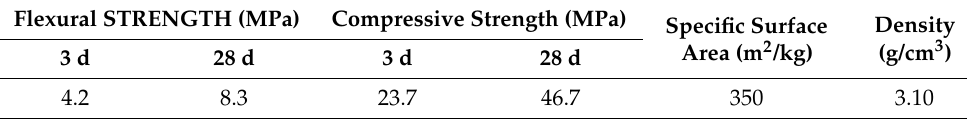
Figure 2. The XRD patterns of ITP ( a ) and ( b ) particle size distribution of the cementitious materials. Table 1. Physical properties of